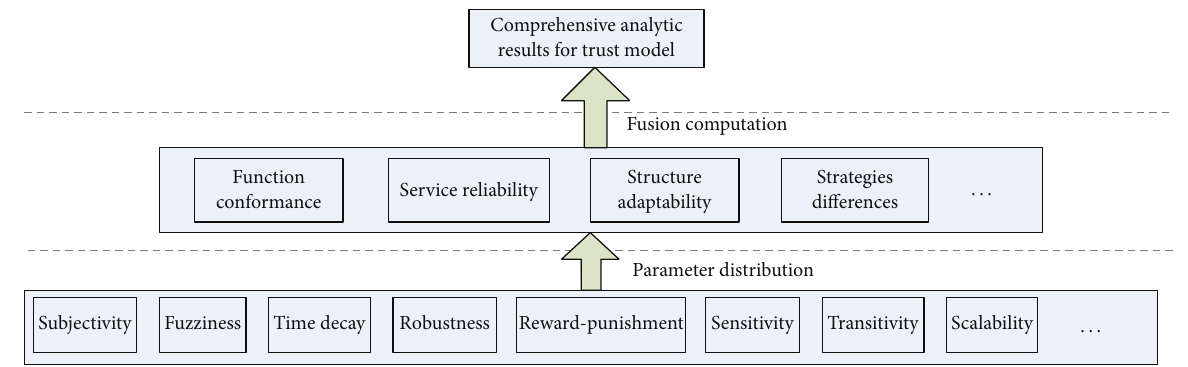
Figure 1: Hierarchical structure of parameters for trust